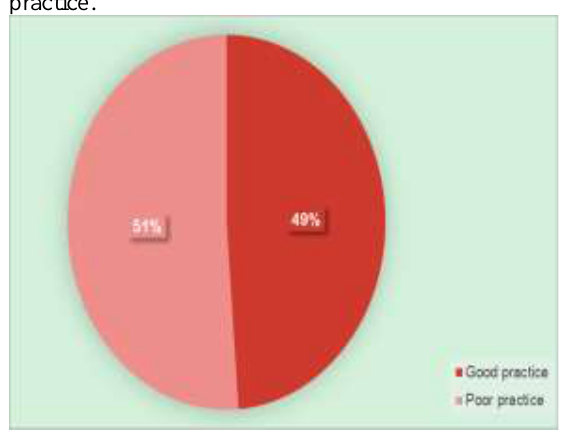
Figure 4. The community pharmacists’ practice level Table 7. Association between sociodemographic characteristics and community pharmacists’ practice level.